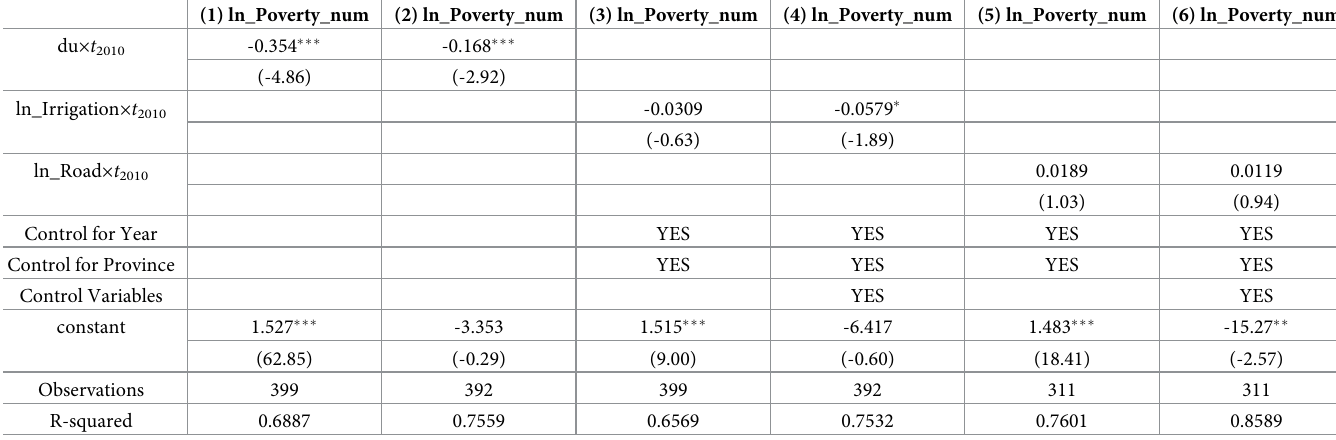
Table 7. Result of changing the dependent